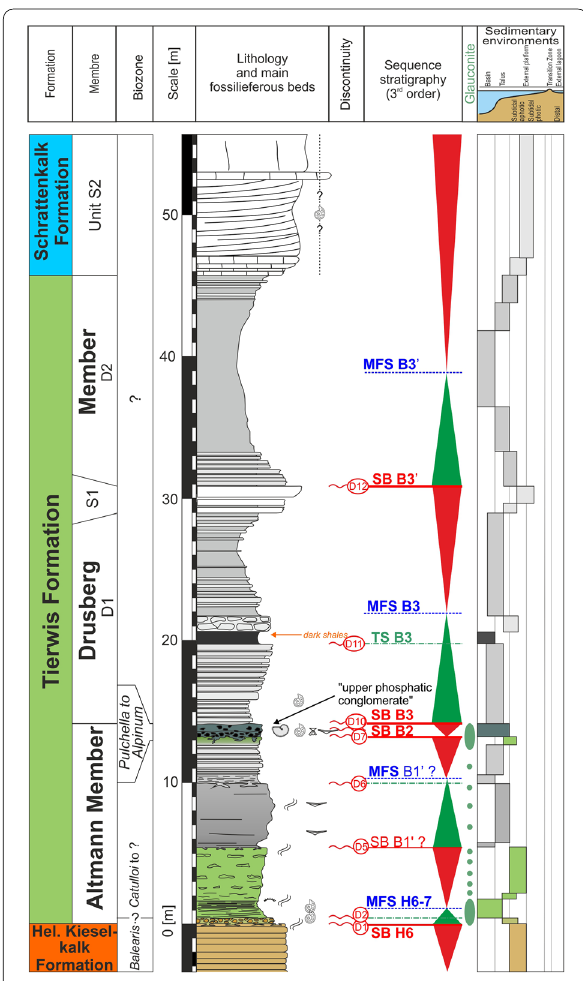
Fig. 9 Altmann section. Lithological log with main fossil-bearing levels, discontinuities, sequence stratigraphic interpretations and